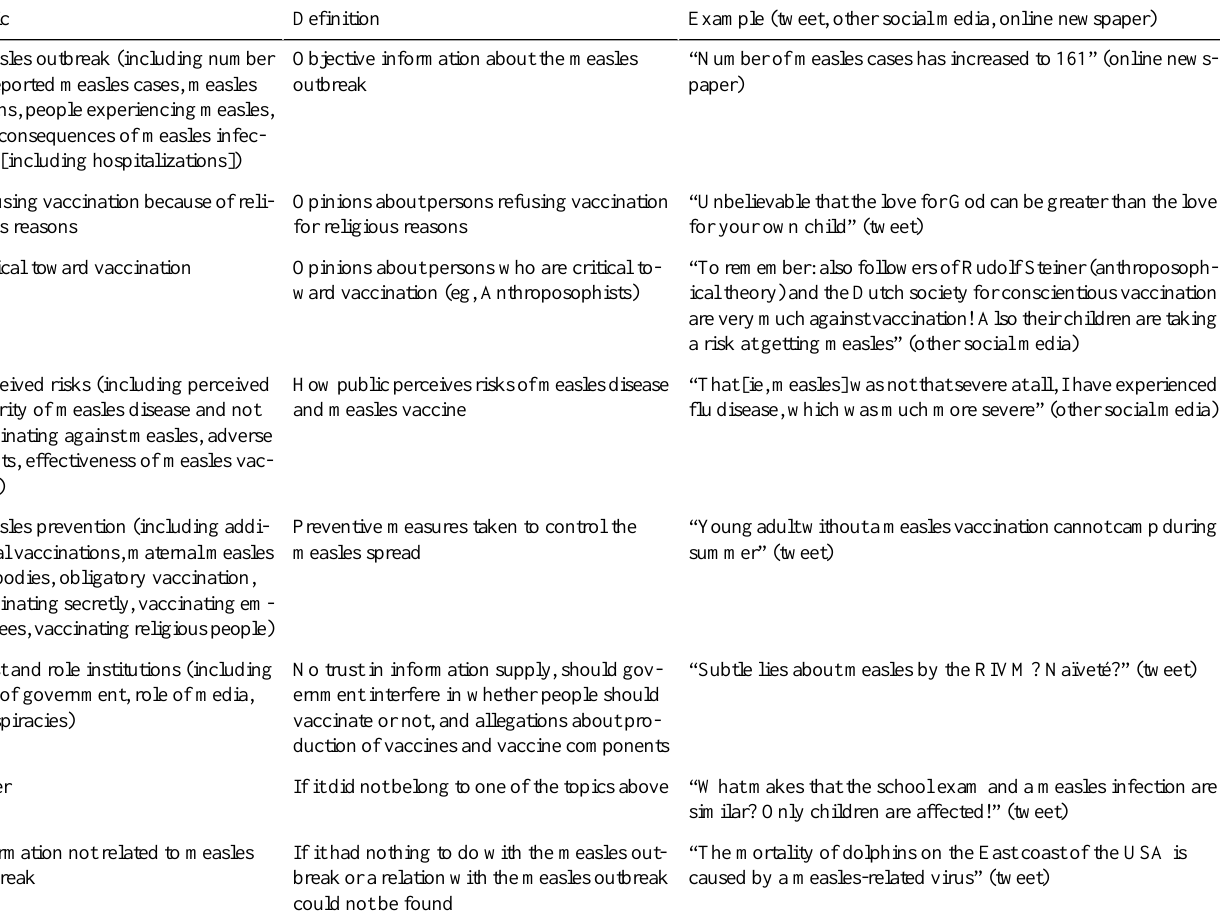
Table 1. Topics and subtopics (between parentheses) of tweets, other social media, and online newspapers about the measles outbreak or perceived